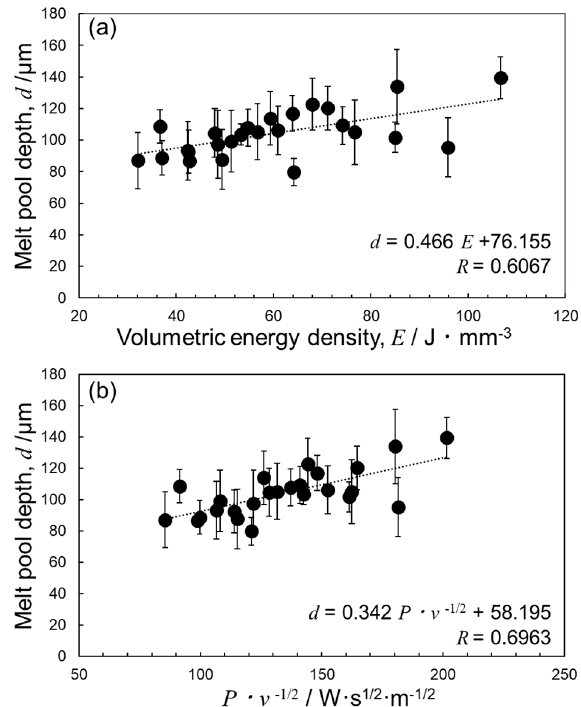
Figure 10. Melt pool depth as functions of ( a ) the volumetric energy density ( E ) and ( b ) P · v − 1 based on the deposited energy density.